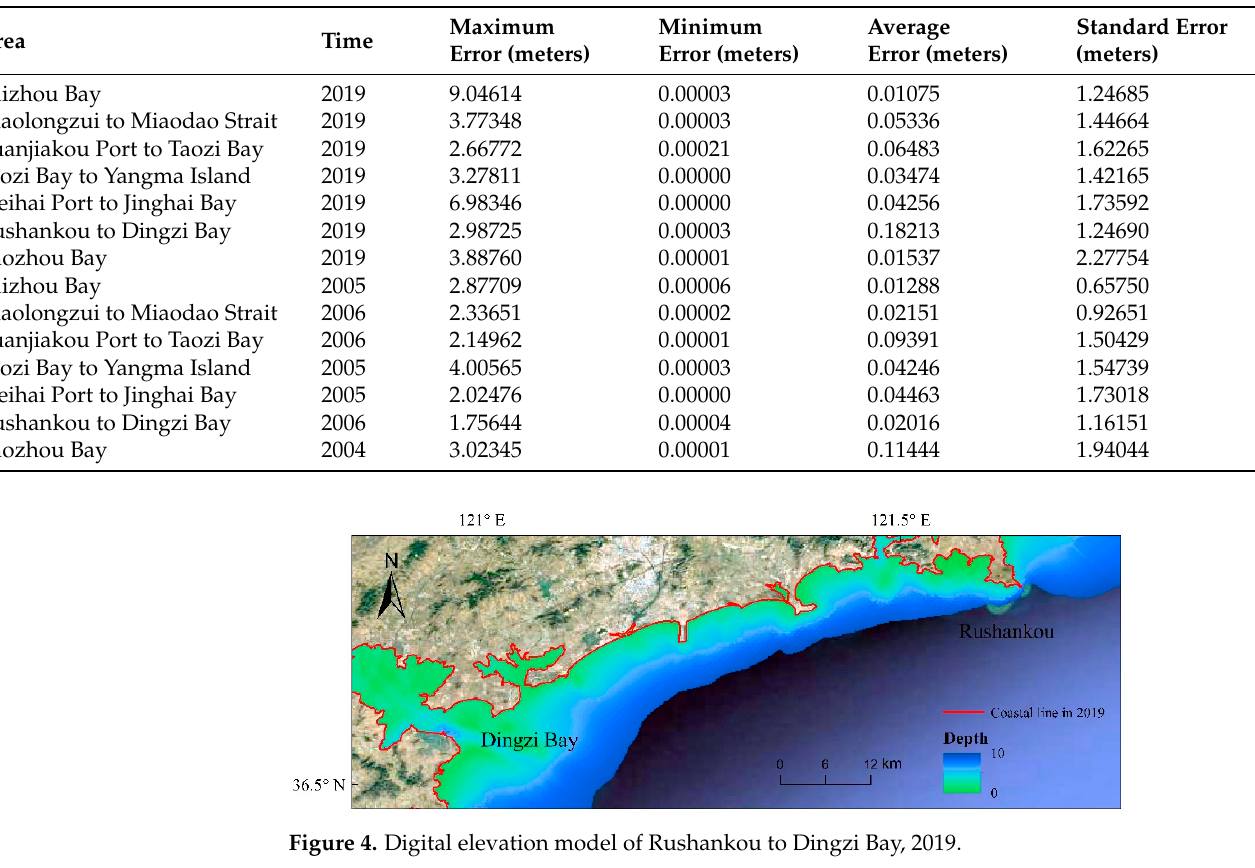
Table 2. Error description of DEMs.